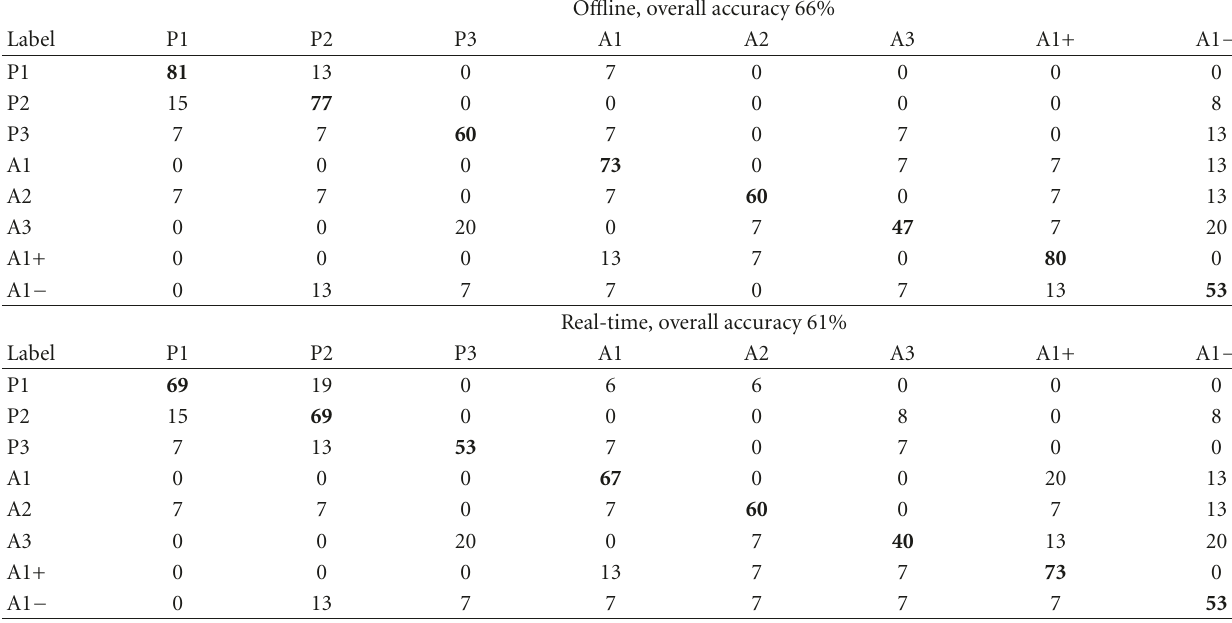
Table 1: Relative classification results for the eight modes of three subjects in an anechoic chamber, the o ffl ine inference results (top, cf. (5)) and the online inference results (bottom, cf. (4)). Row labels indicate target class and columns the percentage of classifying the claps of target class to all classes. Note that, in some cases such as P1 in the top part, the rows do not add to 100% because of the rounding performed in the presentation of the results in a tabular form.